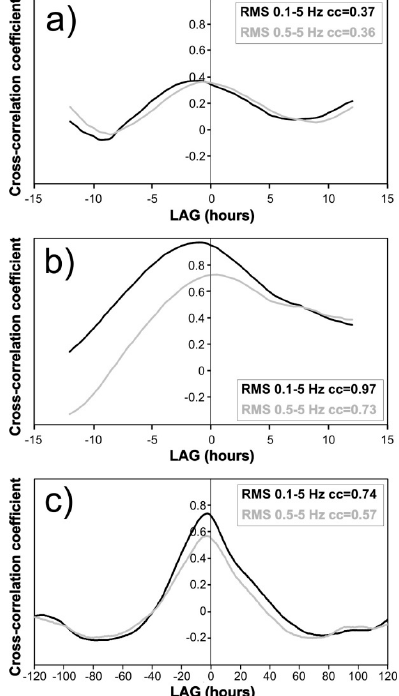
Figure 5. Cross-correlation computed between the RMS 0.1–5 Hz filtered and SWH (black line) and RMS 0.5–5 Hz filtered and SWH (grey line) on ( a ) volcanic tremor (November 4–5, 2002 in Figure 3a), ( b ) oceanographic noise (November 21–22 in Figure 3b) and ( c ) the whole period (November 1, 2002–February 10, 2003). The cc values in the rectangular area represent the correlation coefficient. The lags are negative when seismic RMS follows SWH time